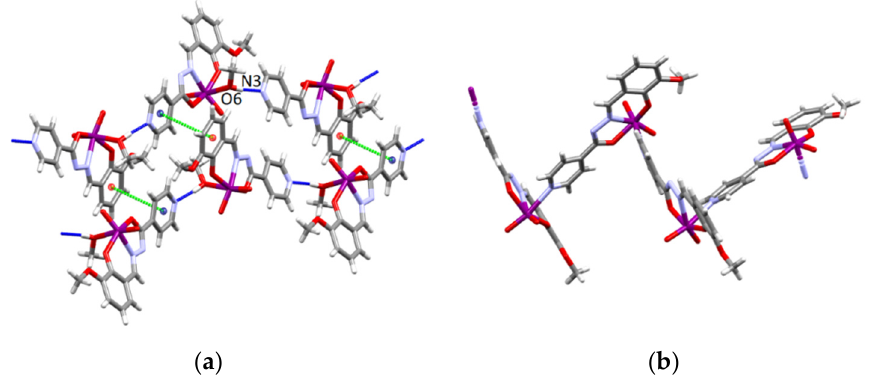
Figure 7. ( a ) Infinite 1D chains in 1 formed through O6 − H61 ⋯ N3 hydrogen bonds. ( b ) Infinite zig– zag chain in the crystal structure of 2 . Hydrogen bonds are shown by blue dotted lines. Green dashed lines indicate π − stacking interactions (Cg3 is centre of gravity of the pyridyl ring, blue spheres and Cg4 is centre of gravity of the phenyl ring, red spheres).